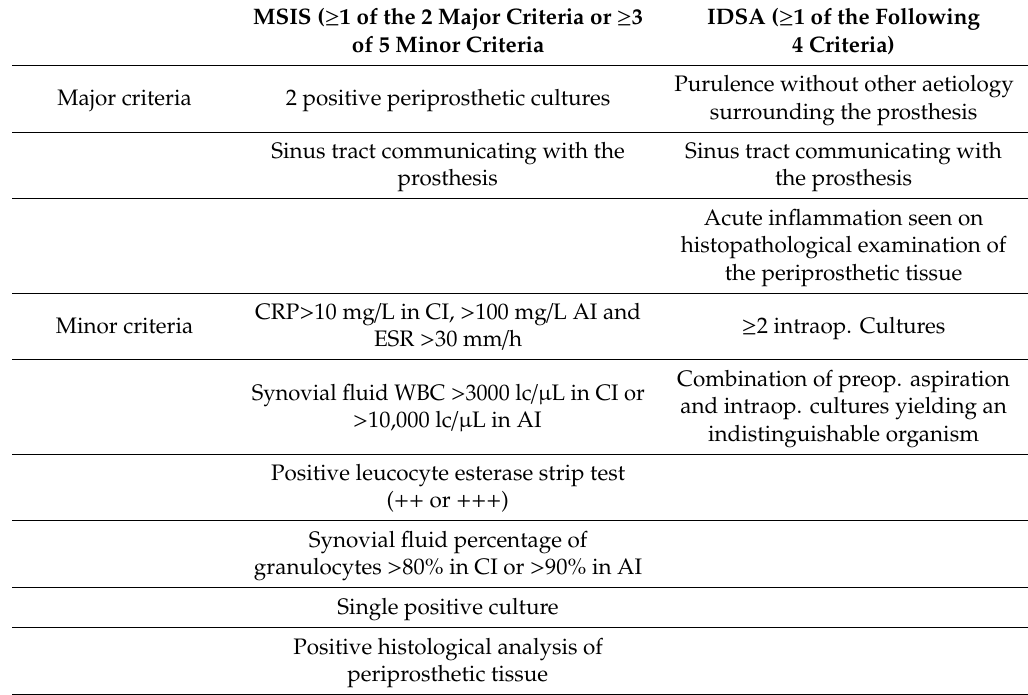
MSIS—Musculoskeletal Infection Society and IDSA—Infectious Diseases Society of America classification for periprosthetic joint infection; CI—chronic infection, AI—acute infection, CRP—c-reactive protein, lc—leucocytes adopted from